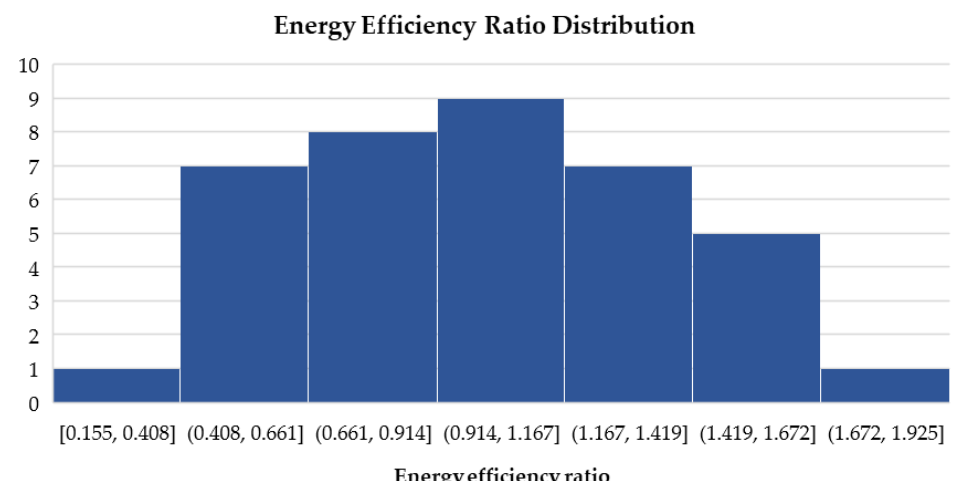
Figure 4. Distribution of the energy efficiency ratios.